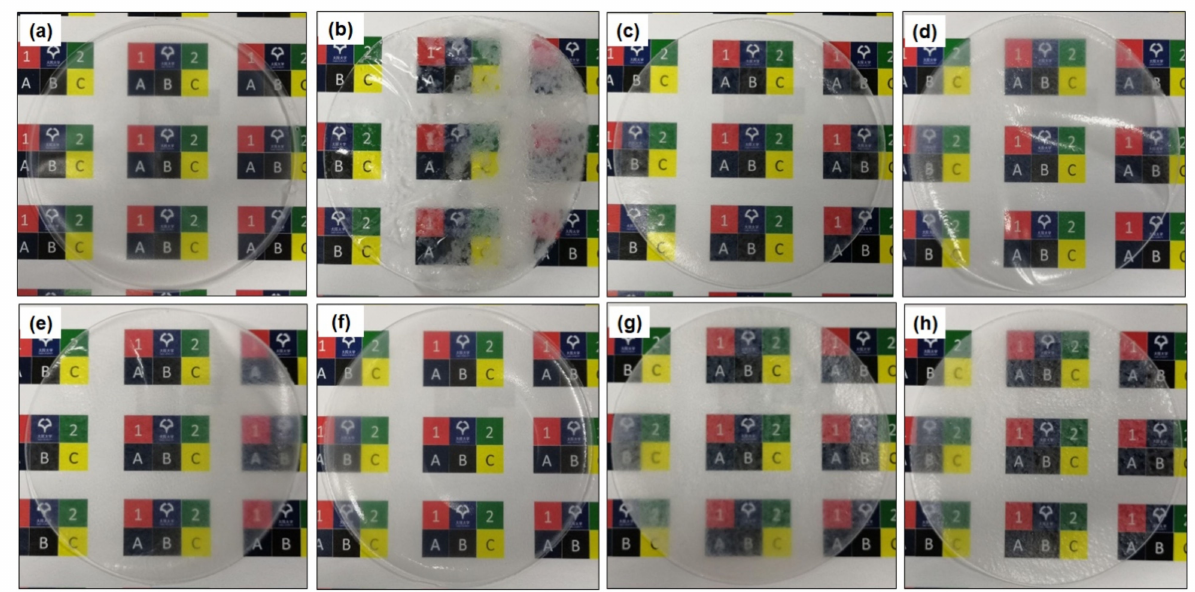
Figure 5. Photographs of the ( a ) neat PLA, ( b ) PLA/CNF, ( c ) PLA/CNFa2, ( d ) PLA/CNFa4, ( e ) PLA/CNFp2, ( f ) PLA/CNFp4, ( g ) PLA/CNFb2, and ( h ) PLA/CNFb4 composite